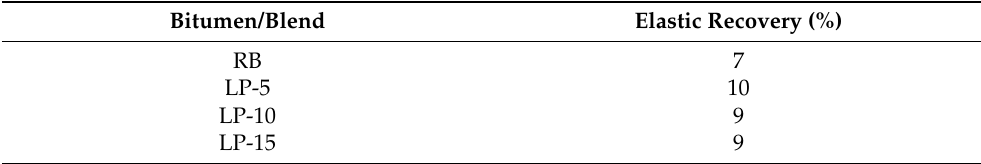
Table 4. Elastic recovery results.